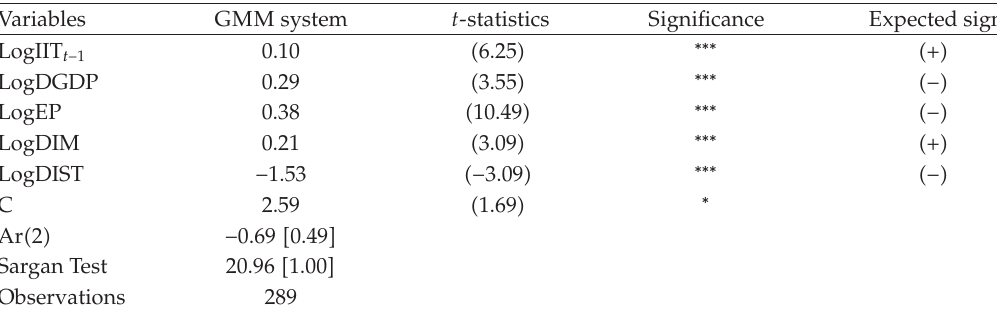
Figure 2: Distribution of intraindustry trade (cid:2) IIT (cid:3) . Table 3: Determinants of intraindustry trade.